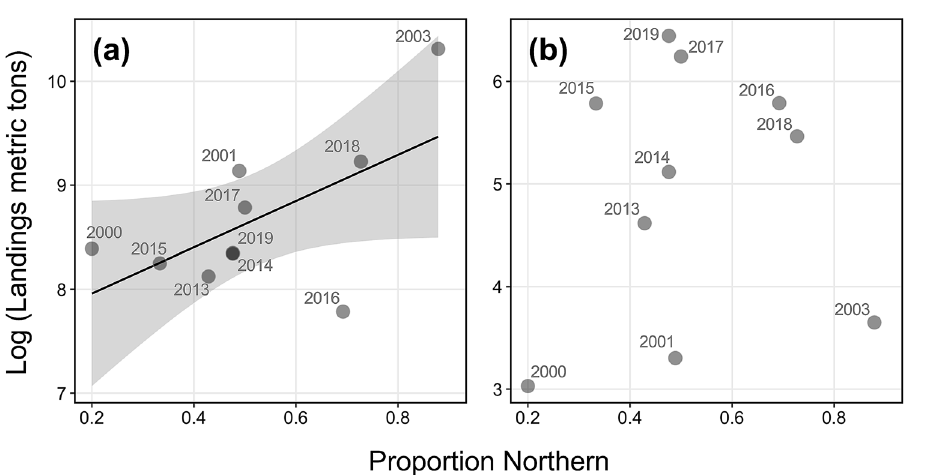
Figure 7. Relationship between the estimated annual proportion of northern contingents of assigned fish (probability > 0.7) occurring within the US shelf waters and ( a ) combined top three monthly US commercial landings during November to April and ( b ) combined landings from July to October. Data points are labeled by year of capture. The black line indicates the linear regression line fitted to the data and the shaded area indicates 95% confidence intervals. Note that the scale of the y-axis differs among